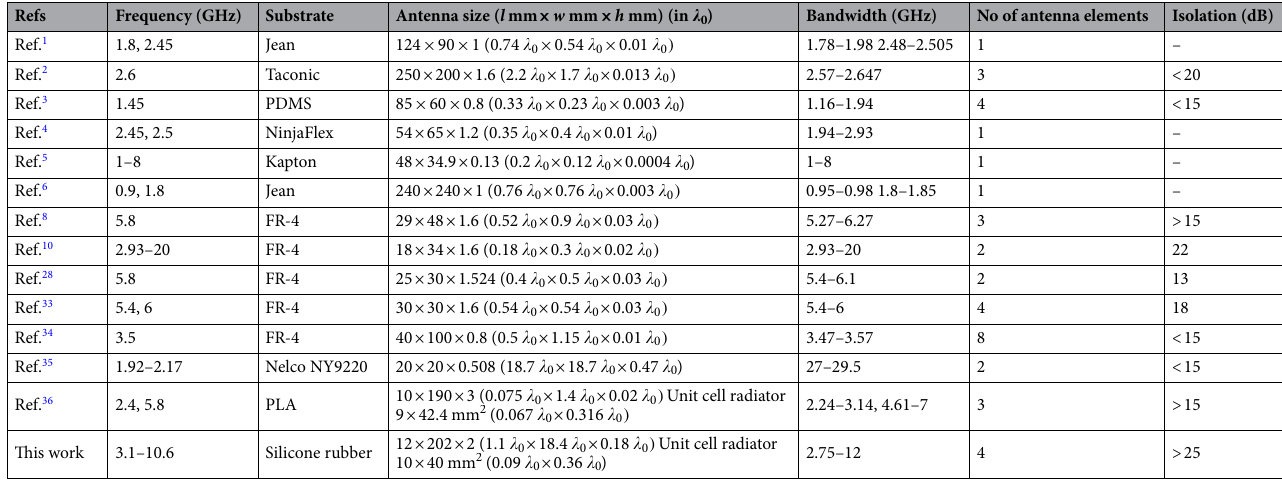
Table 2. Comparison of proposed work with the reported